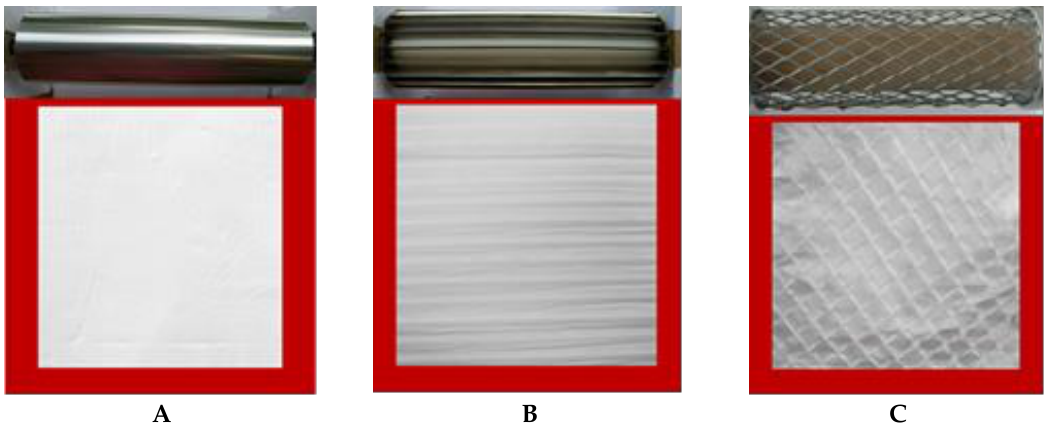
Figure 2. Digital photos of the rotating collectors used — drum ( A ), blade ( B ) and grid ( C ) — and photos of the fabricated PHB/PCL mats, respectively.